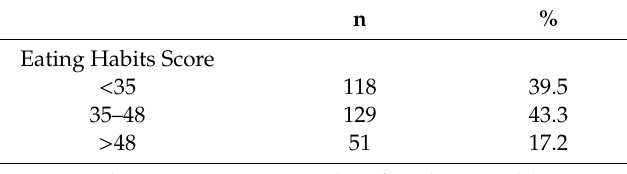
Table 3. Eating habits score distribution.